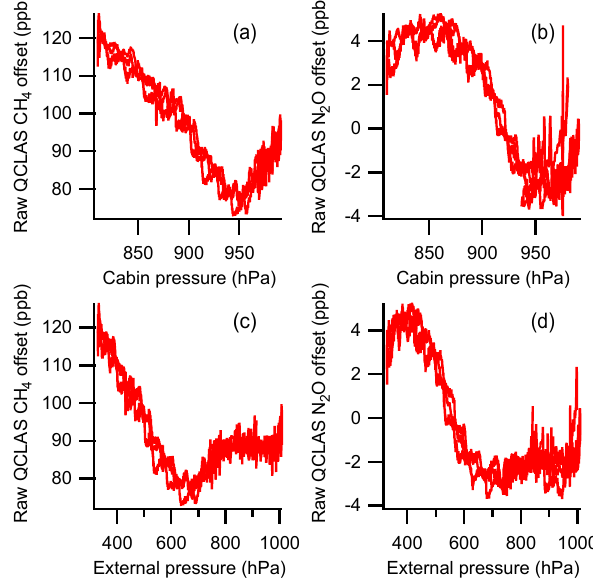
Figure 7. The offset between the raw retrieved QCLAS mole frac- tions and the known content of a target cylinder, sampled continu- ously during three separate deep profiles during flight B903. Panels (a) and (b) shown the offset as a function of the pressure inside the cabin, for CH 4 and N 2 O respectively. Panels (c) and (d) show the offset as a function of external static pressure (also for CH 4 and N 2 O